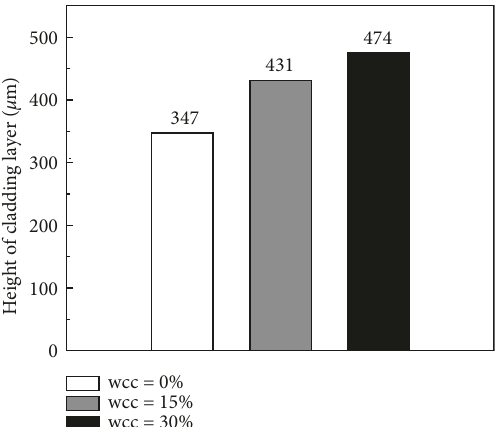
Figure 6: Influence of the WC powder content on the cladding layer height.